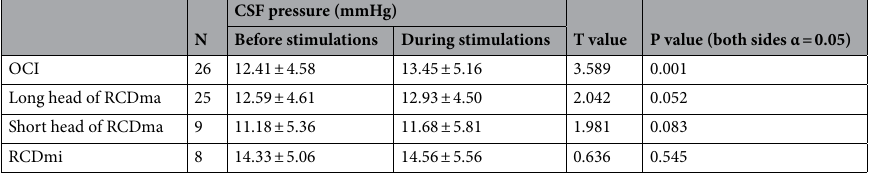
Table 1. The effects of electrical stimulation of muscles on the CSF pressure